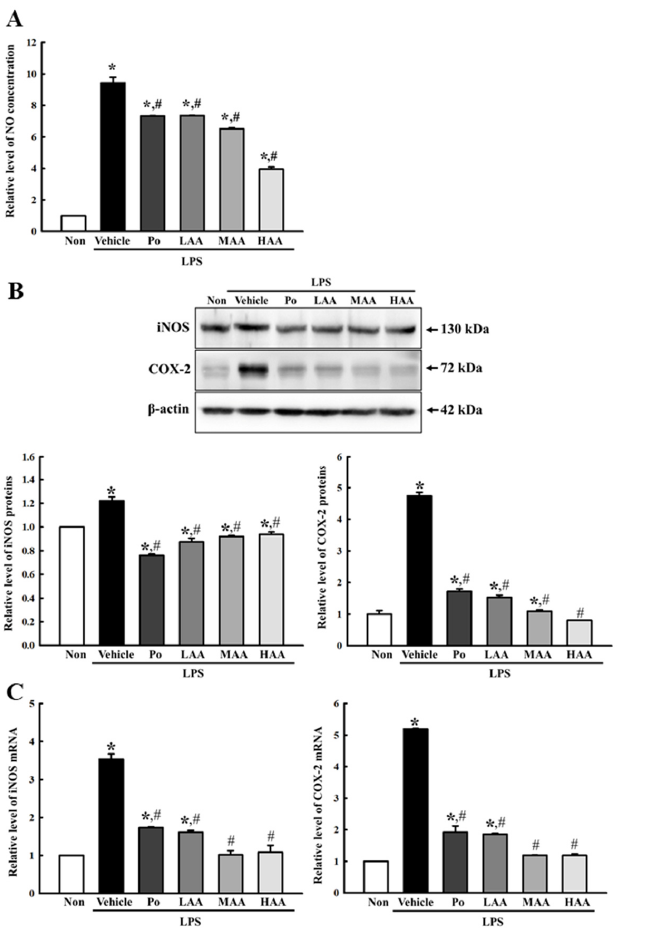
Figure 4. Regulation of the NO-producing system in LPS-stimulated RAW264.7 cells treated with AA. ( A ) NO concentration. NO assay was performed on three wells per group, the optical density was analyzed in duplicate. ( B ) iNOS and COX-2 protein expression. Total cell lysates were added to three to five wells per group and Western blot analyses for each sample were performed in duplicate. ( C ) iNOS and COX-2 mRNA transcription. Total RNA was added to three to five wells per group, and RT-qPCR analyses for each sample were performed in duplicate. ( D ) Expression level of key members of the MAPK signaling pathway. The phosphorylation level of each protein was calculated as a ratio of phosphorylated and unphosphorylated forms. Total cell lysates were added to three to five wells per group, and Western blot analyses were performed for each sample in duplicate. All values in the results are represented as the means ± standard deviation (SD). * indicates statically significance compared to the non-treated group, while # indicates statistical significance compared to the Vehicle+LPS-treated group. Abbreviations: AA, abietic acid; LPS, lipopolysaccharide; Po, positive control; LAA, low concentration of AA; MAA, medium concentration of AA; HAA, high concentration of AA; iNOS, inducible nitric oxide synthase; COX-2, cyclooxygenase-2; ERK, extracellular signal-regulated kinase; JNK, c-Jun N-terminal kinase .